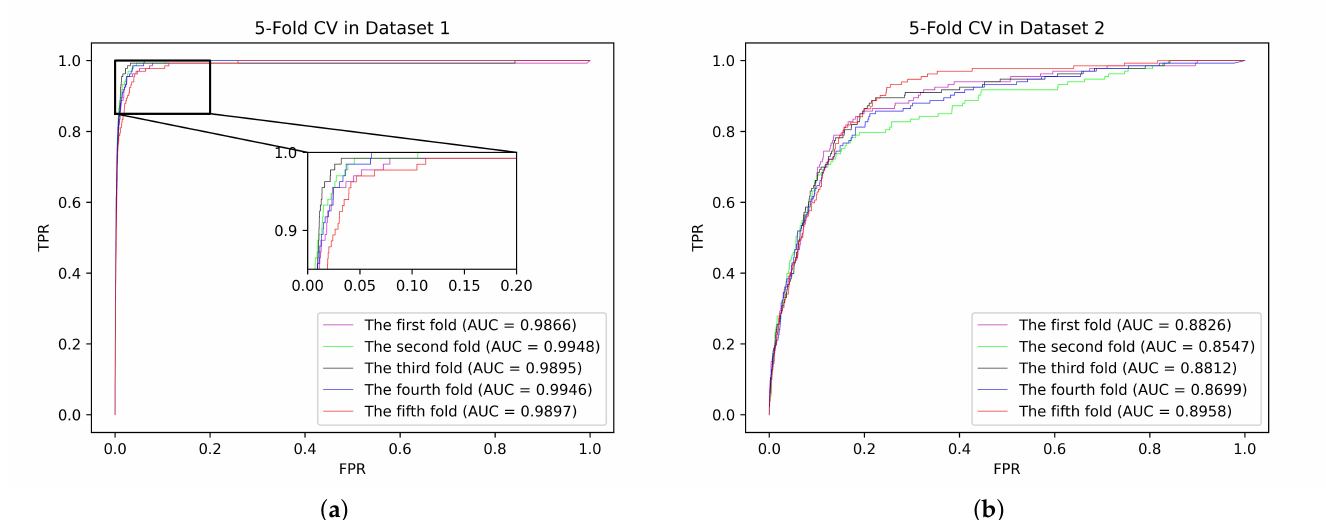
Figure 4. ( a ) The ROC curves and AUC values of five folds based on Dataset 1. ( b ) The ROC curves and AUC values of five folds based on Dataset